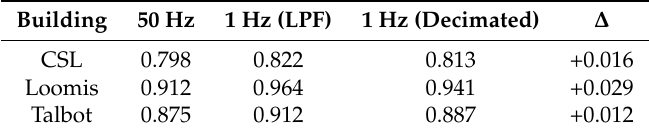
Table 2. Average ρ max between the coexistent Illinois traces before and after LPF/decimation.